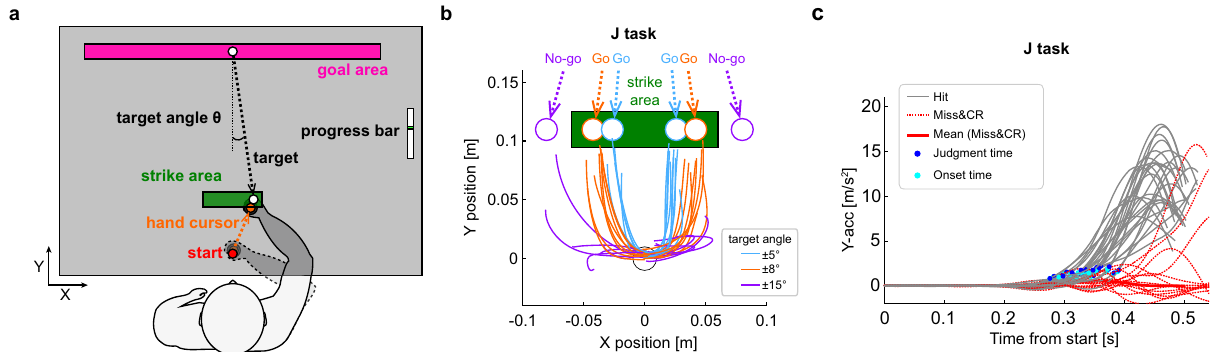
Fig. 1 Experimental setup and typical hand trajectories. a Schematic of the experimental setup using the manipulandum system. Participants were instructed to hit a moving target in the strike area (green square) by manipulating their hand cursor (orange circle) from the start position (red circle) so as to send the target into the goal zone (magenta square). b Potential target positions and typical hand trajectories for a representative participant. Targets passed through the strike area (Strike targets; ±5 (cyan), ±8° (orange)) or outside (Ball targets; ±15° (purple)) with different TTCs (0.4 s, 0.5 s, or 0.6 s). Target (dashed lines) and hand trajectories (solid lines) at 0.5 s TTC in J task are displayed as examples. c Typical hand acceleration pro fi les in the forward (y) direction at 0.5 s TTC for a representative participant. Judgment times (blue circles) were de fi ned as the time at which each Hit trial acceleration (gray line) diverged from the average acceleration for all No-go (CR and Miss) trials (thick red line) in J task. Each CR or Miss trial is indicated by a dashed red line. Movement onset times are shown by cyan